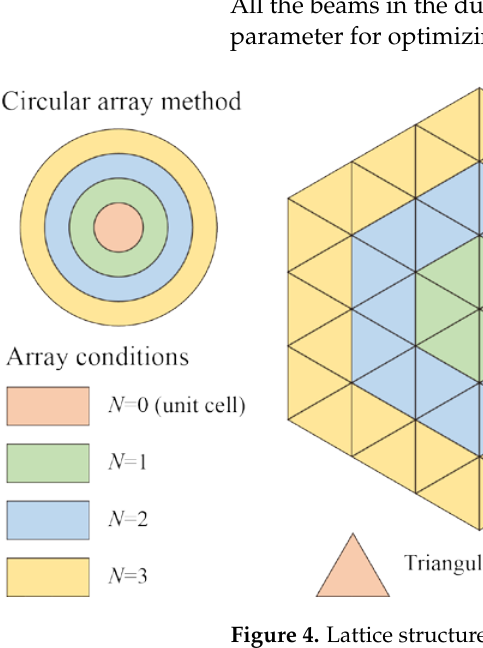
( b ) Figure 3. Schematic illustration of the dual-layer unit cell ( a ) hexagon type; ( b ) triangle type.